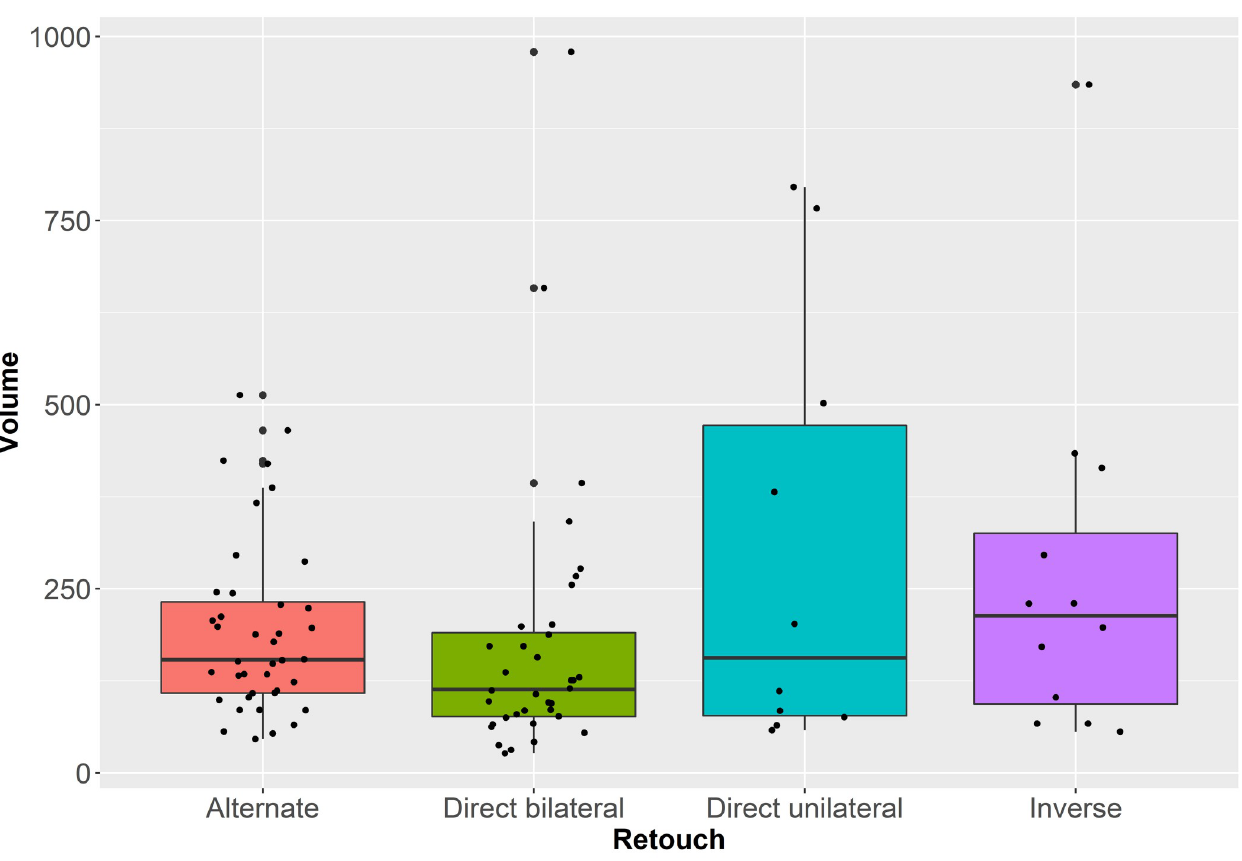
Fig 5. Boxplots with jittered points of volume values (in cubic millimeters) of retouched bladelets sorted according to retouch position. For colors see the legend.